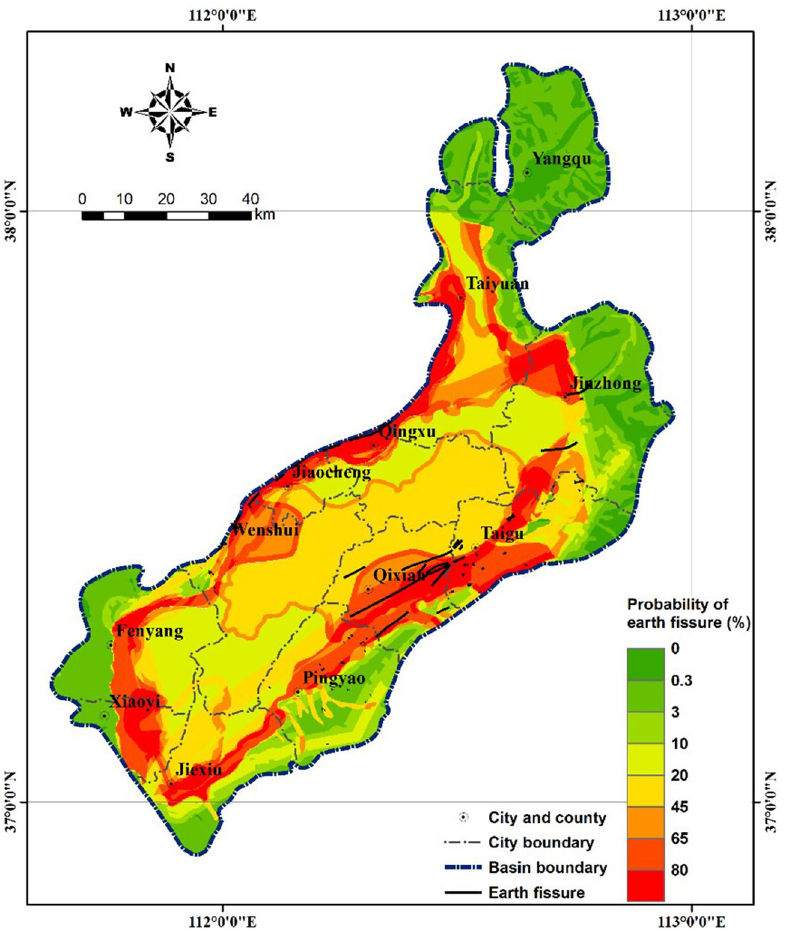
Figure 7. Map showing probability of earth fissures in the study